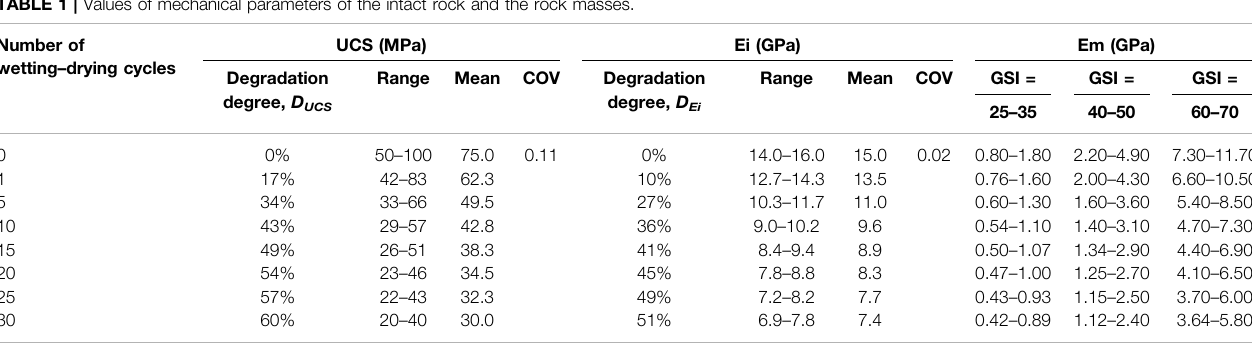
TABLE 1 | Values of mechanical parameters of the intact rock and the rock masses. Number of wetting – drying